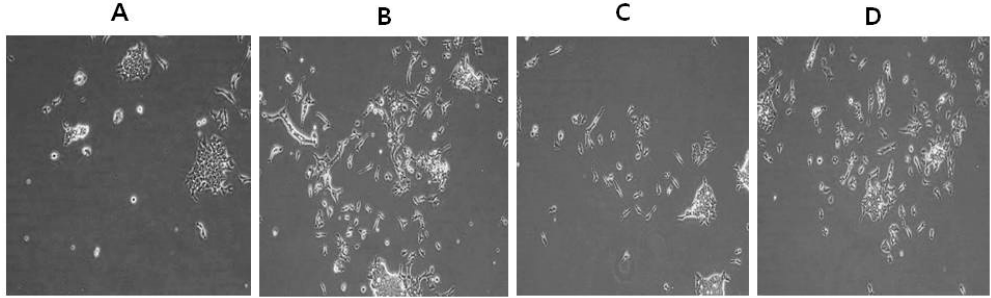
Figure 9. Effects of AuNPs and RA treatment on the differentiation of F9 cells. AuNPs-induced differentiation of F9 cells was determined after 24 h exposure to AuNPs (10 μ M), RA (10 μ M), and RA in the presence of AuNPs (both 10 μ M). Phase contrast microscopy images showing the morphological changes in F9 cells after treatment with AuNPs and RA in 1% serum-supplemented medium. At least three independent experiments were performed for each sample. Control ( A ); AuNPs (10 μ M) ( B ); RA (10 μ M) ( C ); AuNPs and RA ( D ). (The magnification is 100 micro meter).